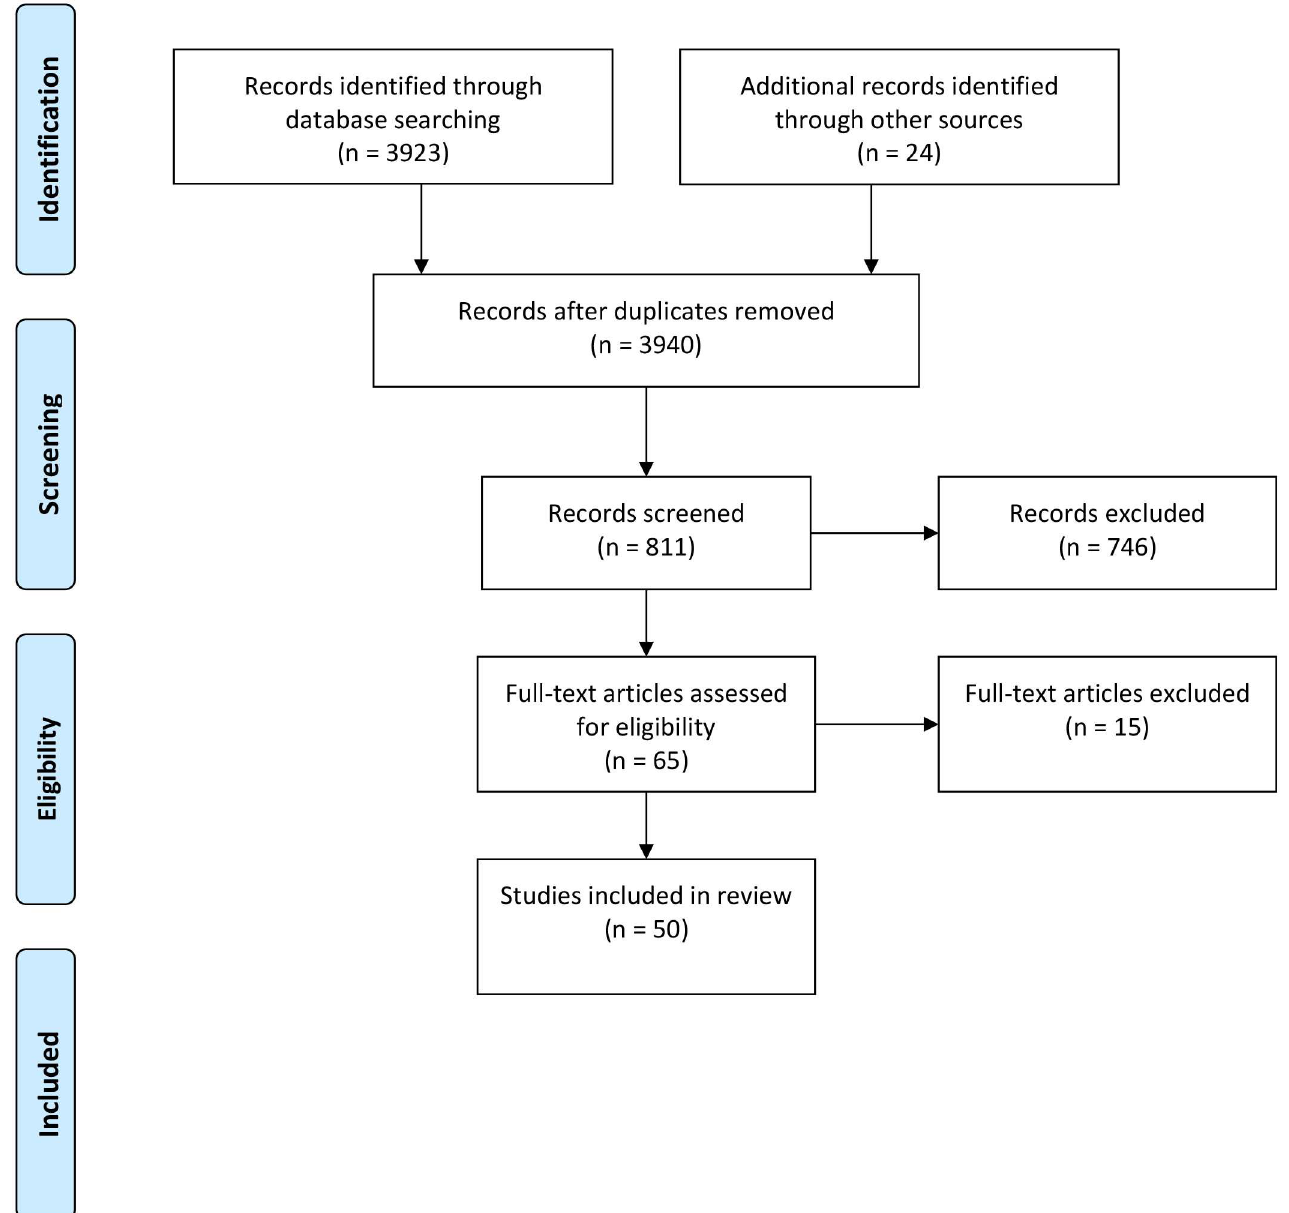
Fig 1. PRISMA Flowchart overview of the results of retrieving, screening and including review papers.